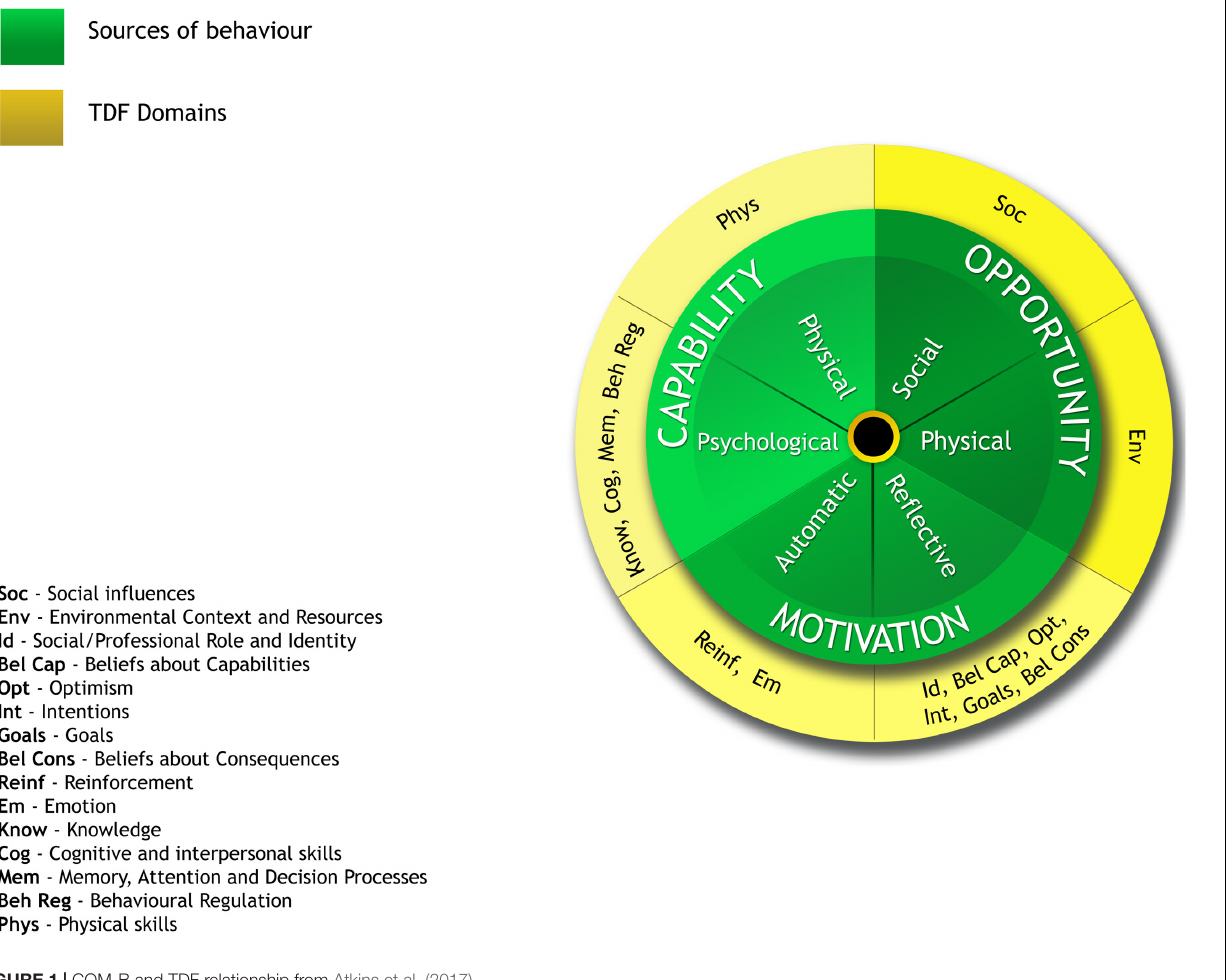
FIGURE 1 | COM-B and TDF relationship from Atkins et al.